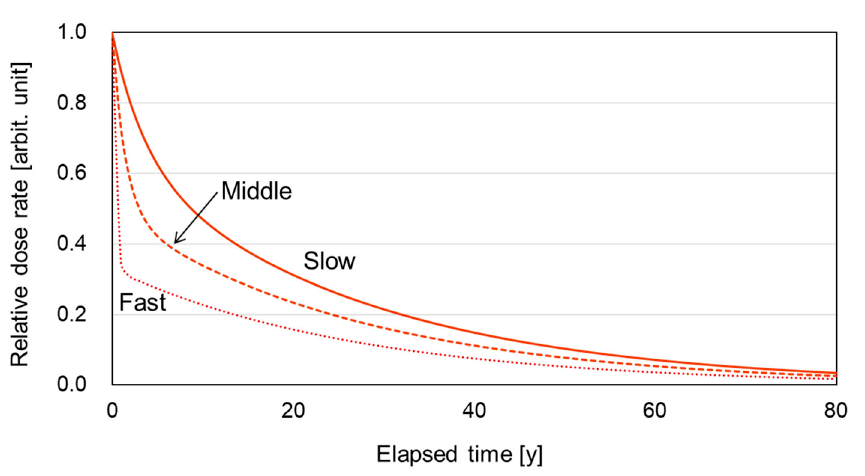
Figure 2. Predicted time change of the relative external dose rates from 137 Cs deposited onto the ground surfaces having different properties.